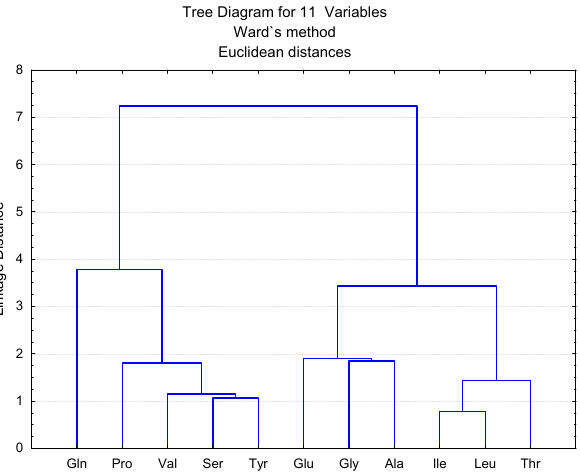
Fig. 6. Cluster analysis dendrogram for 11 amino acids.